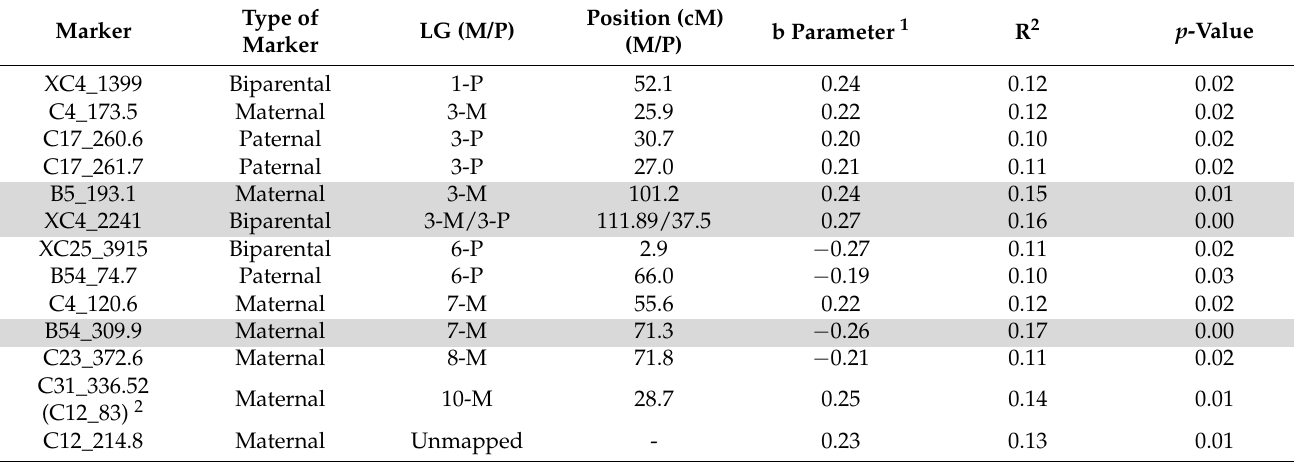
and LG10 showed one marker each (P, M, and M, respectively) (Table 7). The markers with the highest R 2 (>0.15) were found in LG3 and LG7. Table 7. Markers significantly associated with apospory expressivity detected in the F 1-Z population.